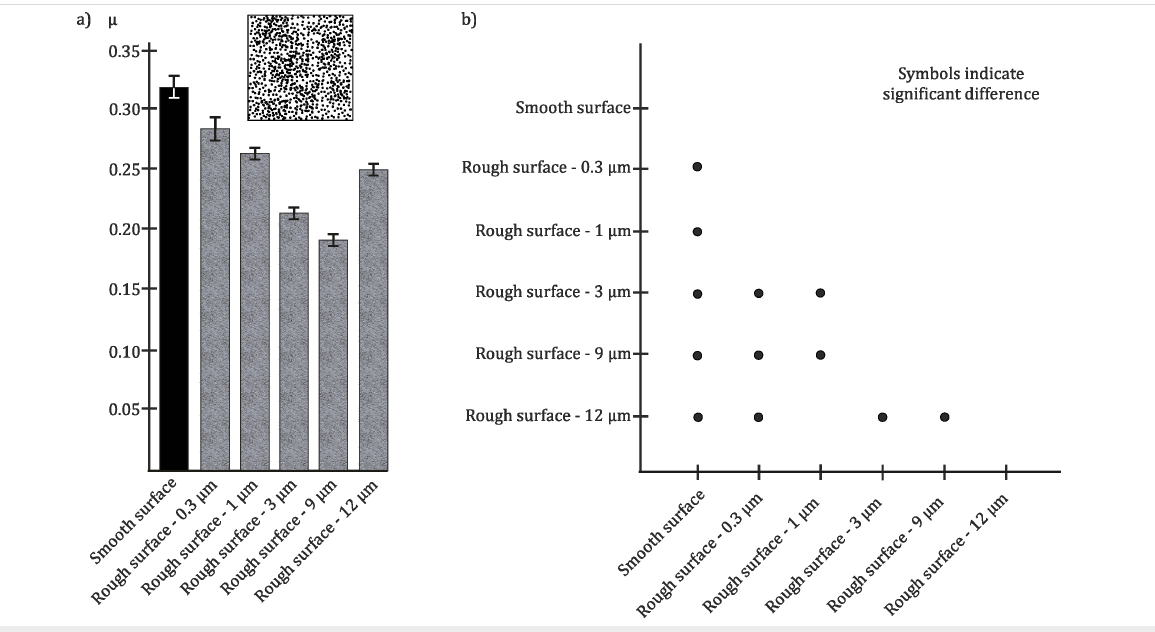
Figure 6: a) Results of tribological characterization of microstructured polymer surfaces in contact with a smooth glass ball. Average frictional coeffi- cients (µ) and standard deviations are shown. Black column: smooth surface as reference. Gray columns: epoxy resin moulds of randomly rough surface with different grain size ( R a : 0.3 µm, 1 µm, 3 µm, 9 µm, and 12 µm). b) Multiple comparison graph of the results presented in a). Dots indicate statistically significant differences between